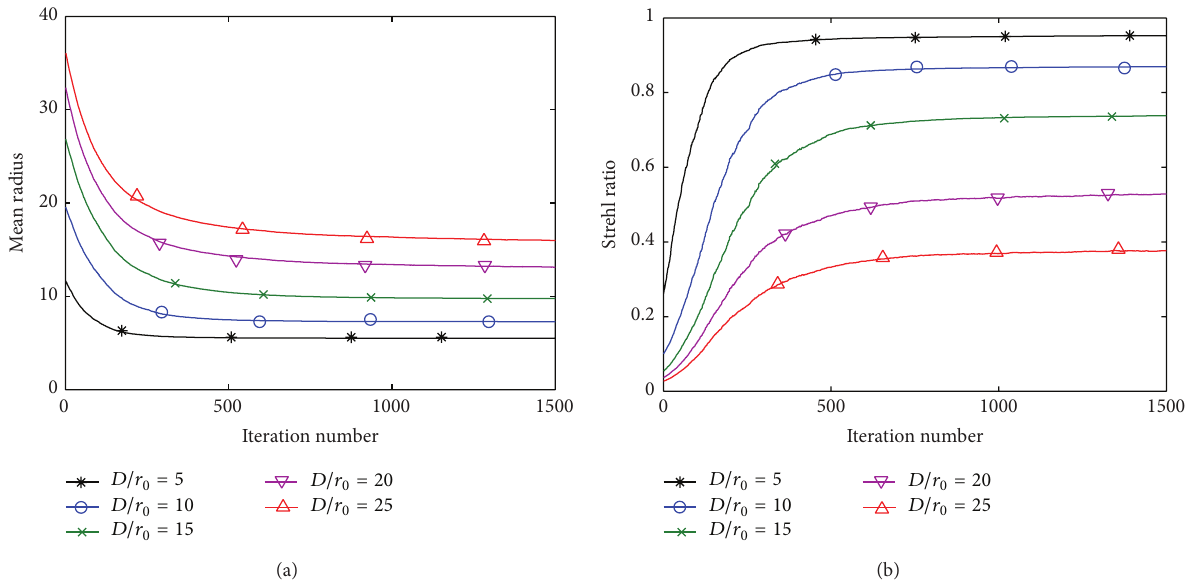
Figure 5: Averaged adaptation process over 500 different phase screens under different turbulence strengths by SPGD algorithm: (a) MR and (b) SR .